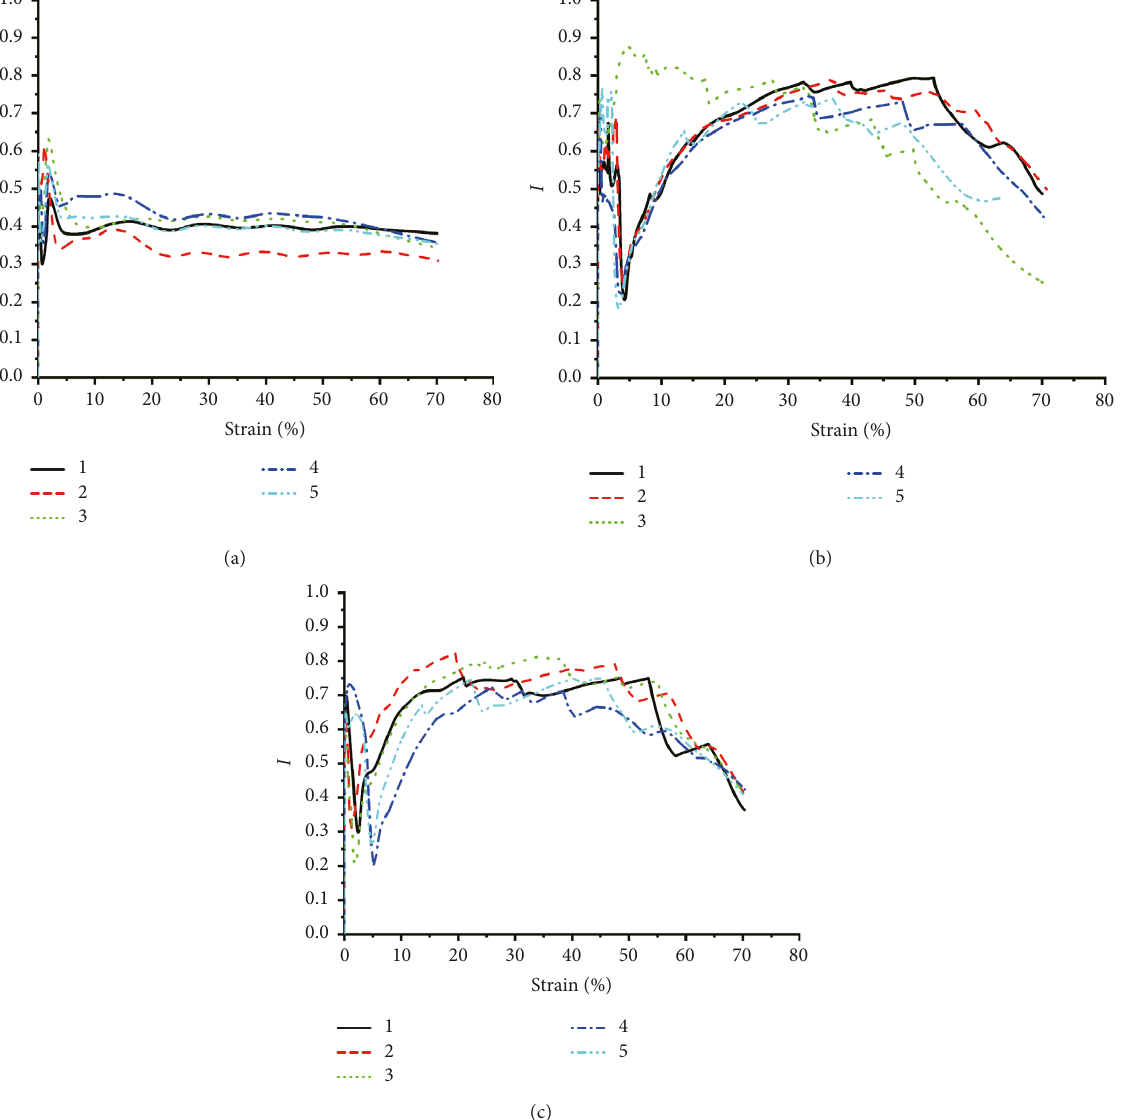
Figure 10: Quasistatic ideal energy absorption efficiency curves of (a) thin-walled pipes, (b) epoxy-bonding APM composite pipes, and (c) epoxy foam-bonding APM composite